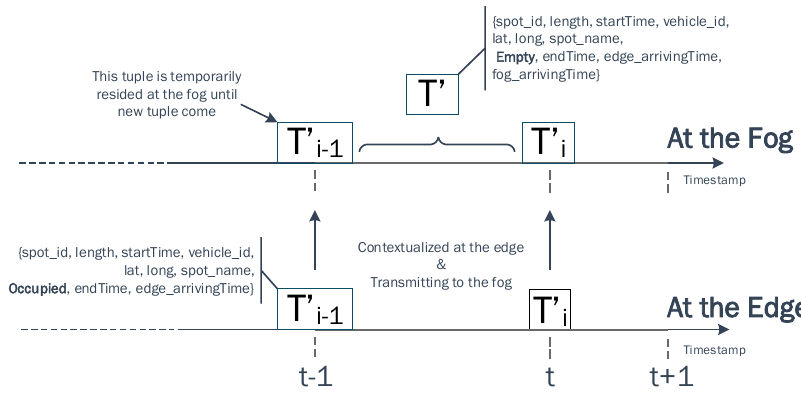
Figure 6. The process of computing an Empty event at the